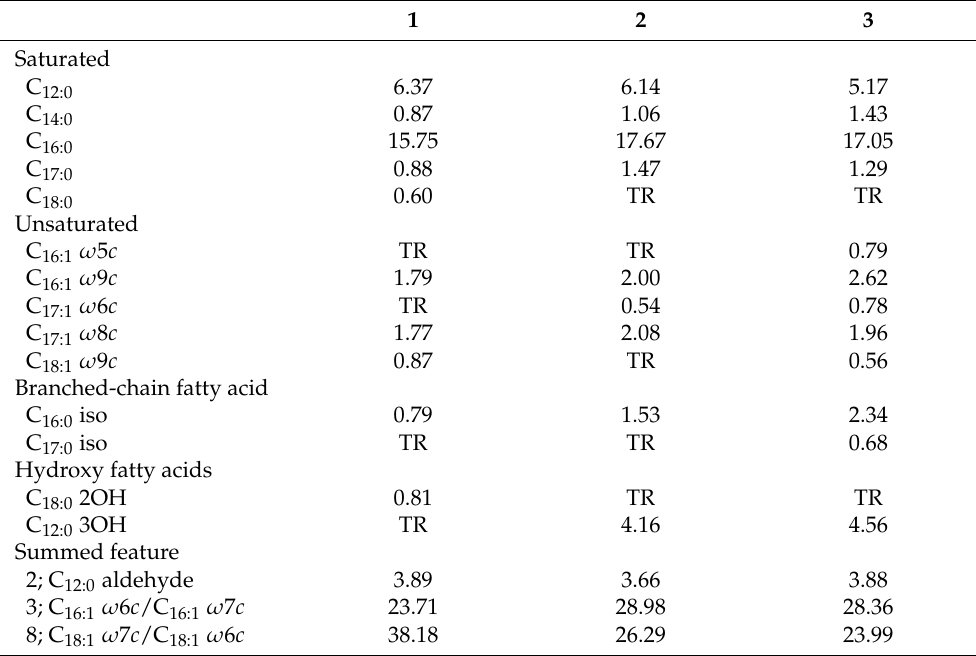
Table 2. Cellular fatty acid profiles (% of totals) of GJ3 T and reference strains of the genus Photobacterium